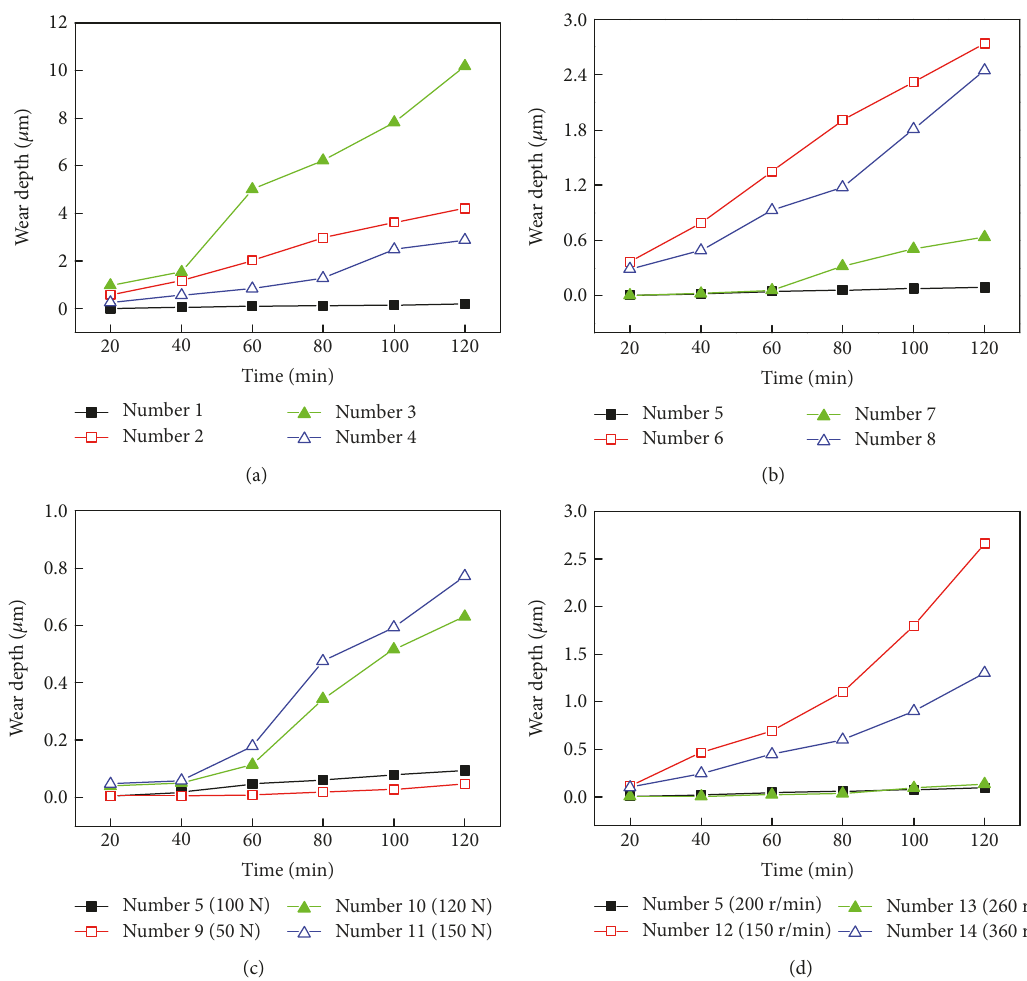
Figure 4: Variations of wear depth with time under di ff erent materials (a), surface treatments (b), loads (c), and rotation speeds (d).